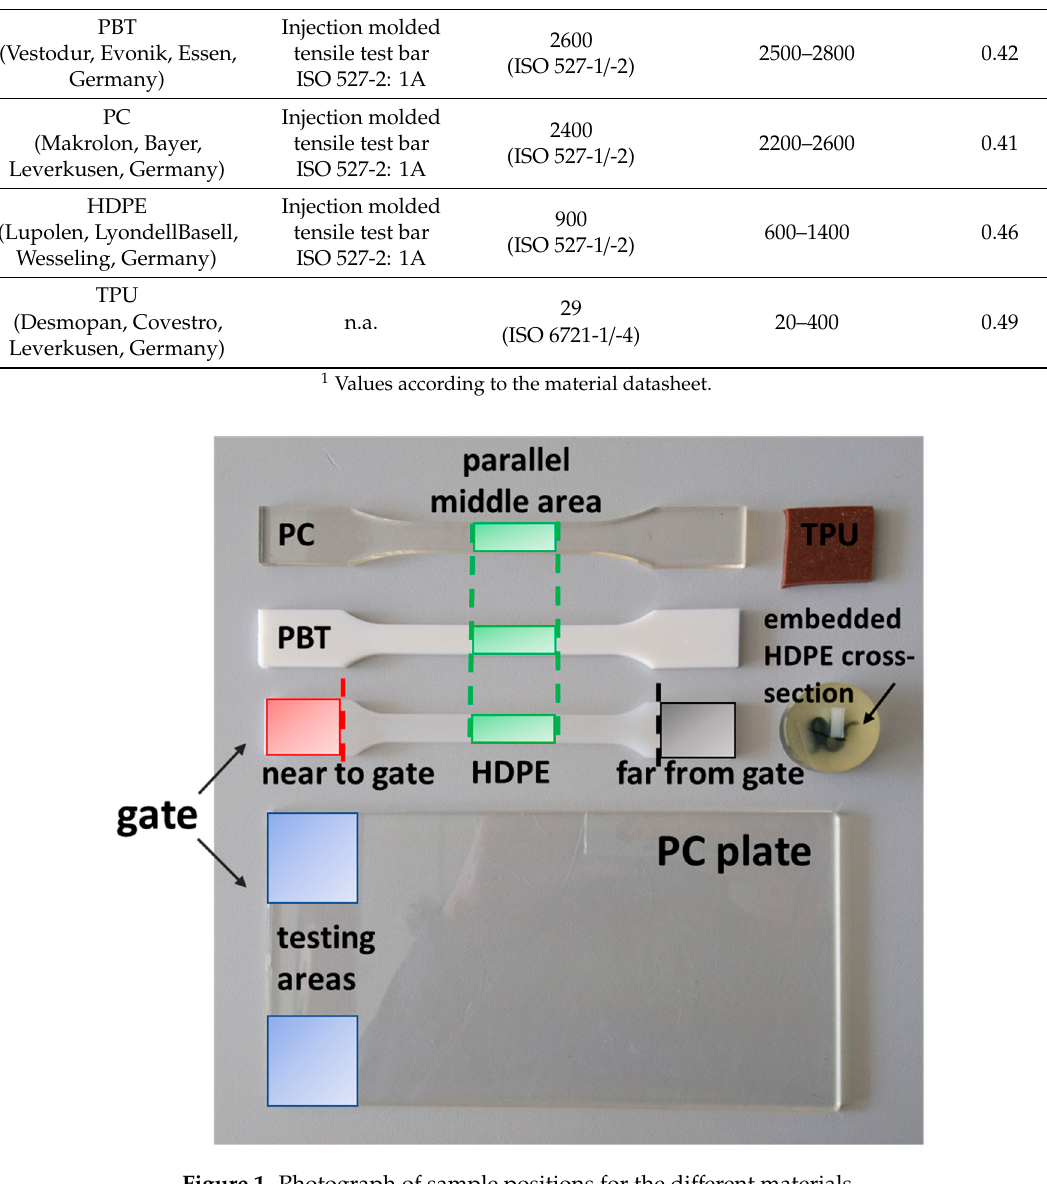
Table 2. Investigated tungsten welding electrodes as cone indenters.